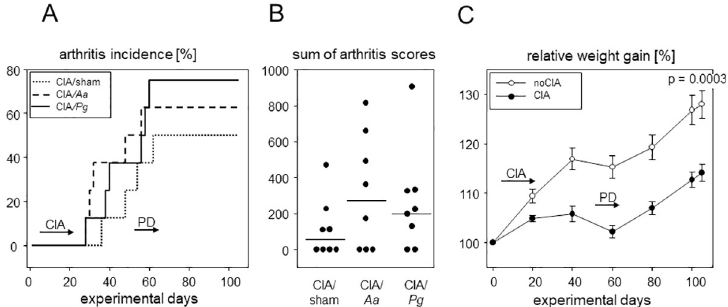
Fig 7. PD did not exacerbate subsequent CIA. (A) Inverted Kaplan-Meier curves show arthritis incidences over time. Horizontal arrows indicate periods of disease inductions. Numbers are n = 8 for all groups. (B) Dot plots summarize the sums of macroscopic arthritis scores at endpoint, assessed every other day starting from boost. (C) Weight curves show delayed weight gains in CIA mice. Symbols represent means ± SEM, numbers are n = 24 each for CIA and noCIA groups. P-value at endpoint resulted from Mann-Whitney test. Every dot represents a single mouse.